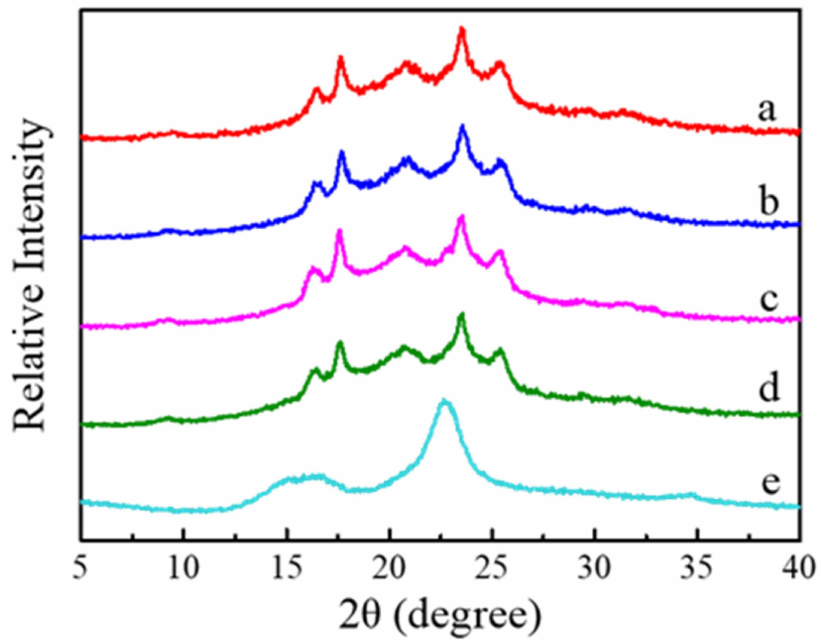
Figure 6. WAXD data for ( a ) g-PBAT-40, (b ) 1 wt% g-PBAT-40/CNC, ( c ) 2 wt% g-PBAT-40/CNC, ( d ) 3 wt% g-PBAT-40/CNC, and ( e ) CNC